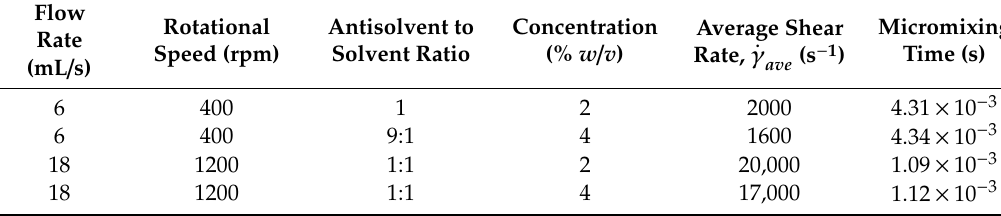
Figure 14. Micromixing time against shear rate for 2% w / v and 4% w / v starch. Table 3. Variation of micromixing time with average shear rate at 2% w / v and 4% w / v .